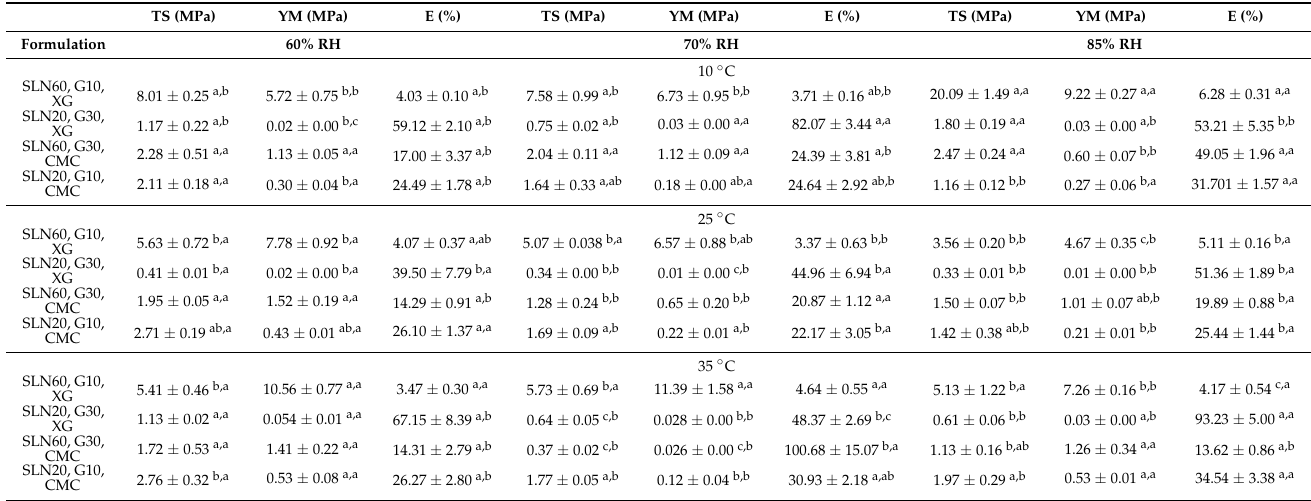
Table 4. Mechanical properties of edible films under different storage